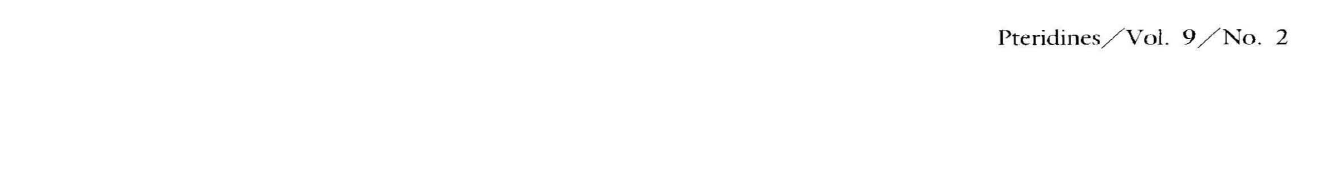
Figure 2. Neopterin and 7 ,8-dihydroneopterin influence cytotoxicity mediated hy reactive species. During cellular imnlune response, among other cytokines interferon-y (IFN-y) is released which triggers production of neopte rin derivatives in human ll1onocytes/ macrophagcs. At the saIne time, variolls reactive species are fornled by these cells and hy various immunocompetent cells in the